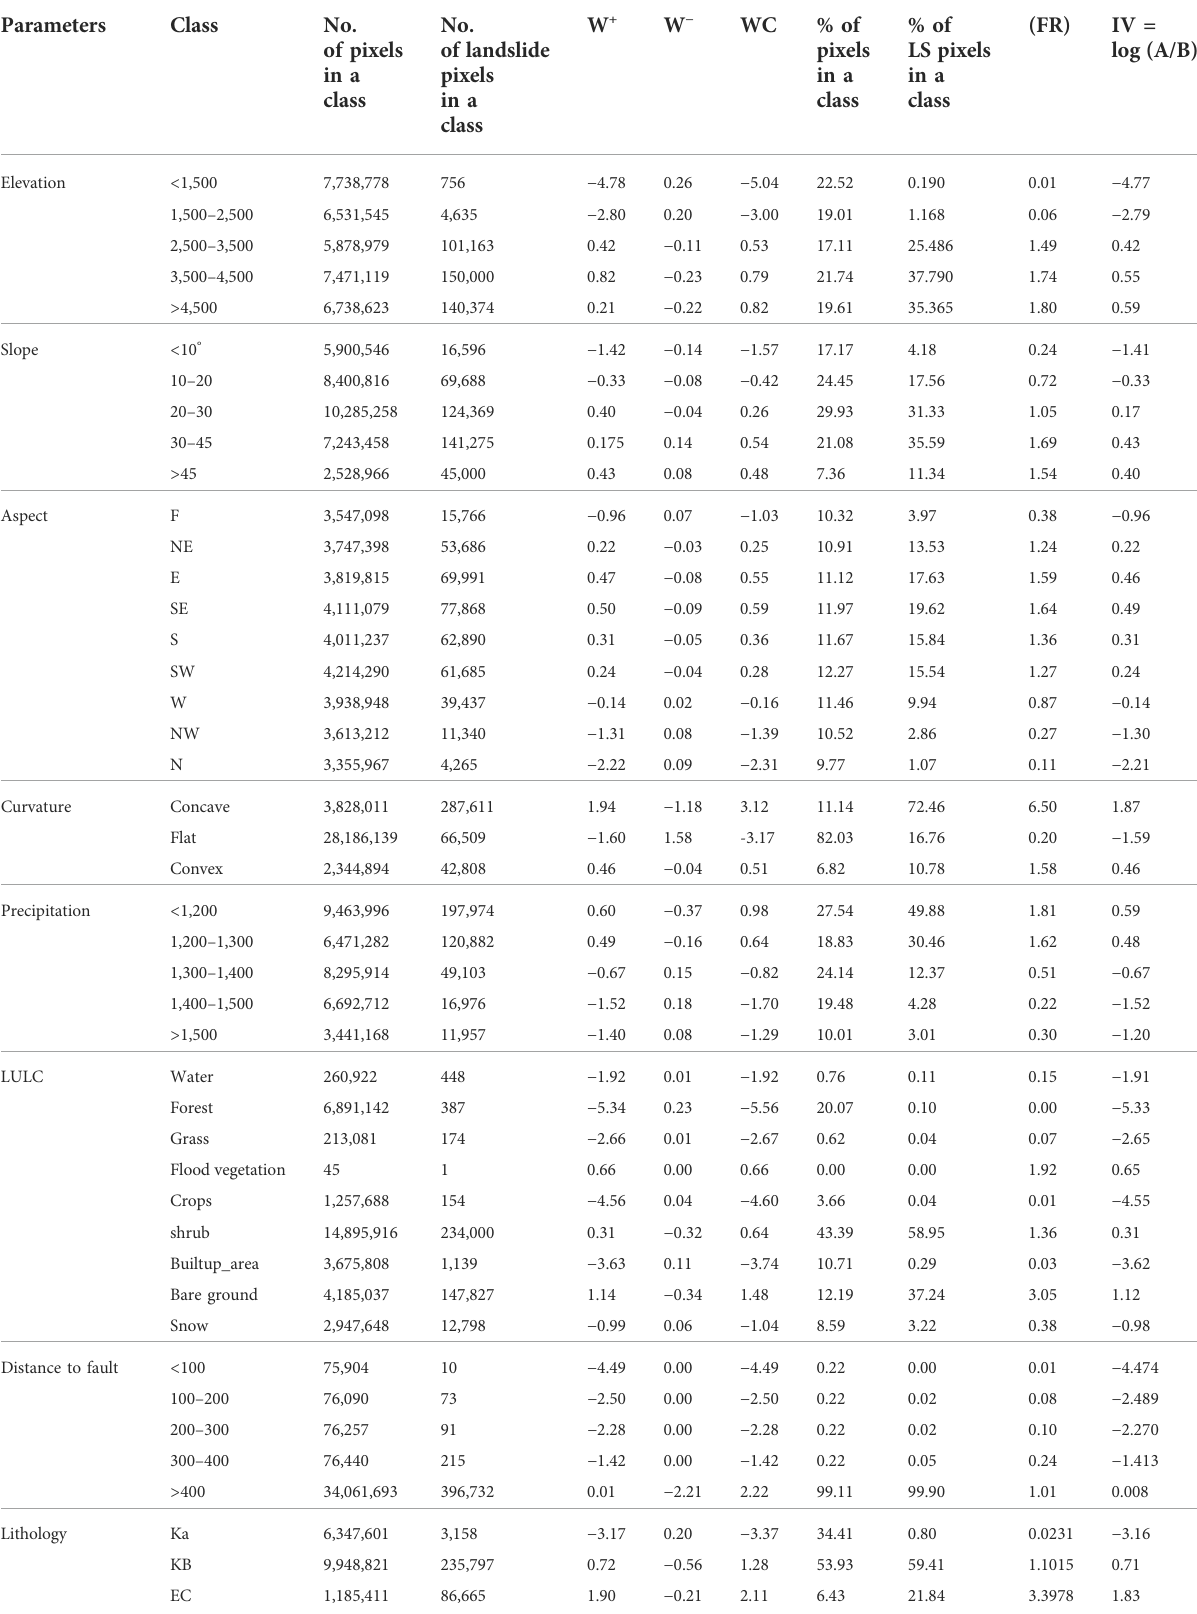
TABLE 2 Detailed analysis of different causative parameters with landslide events using bivariate models (IV, FR, and WoE) to understand the impacts of each class in LSM. Parameters